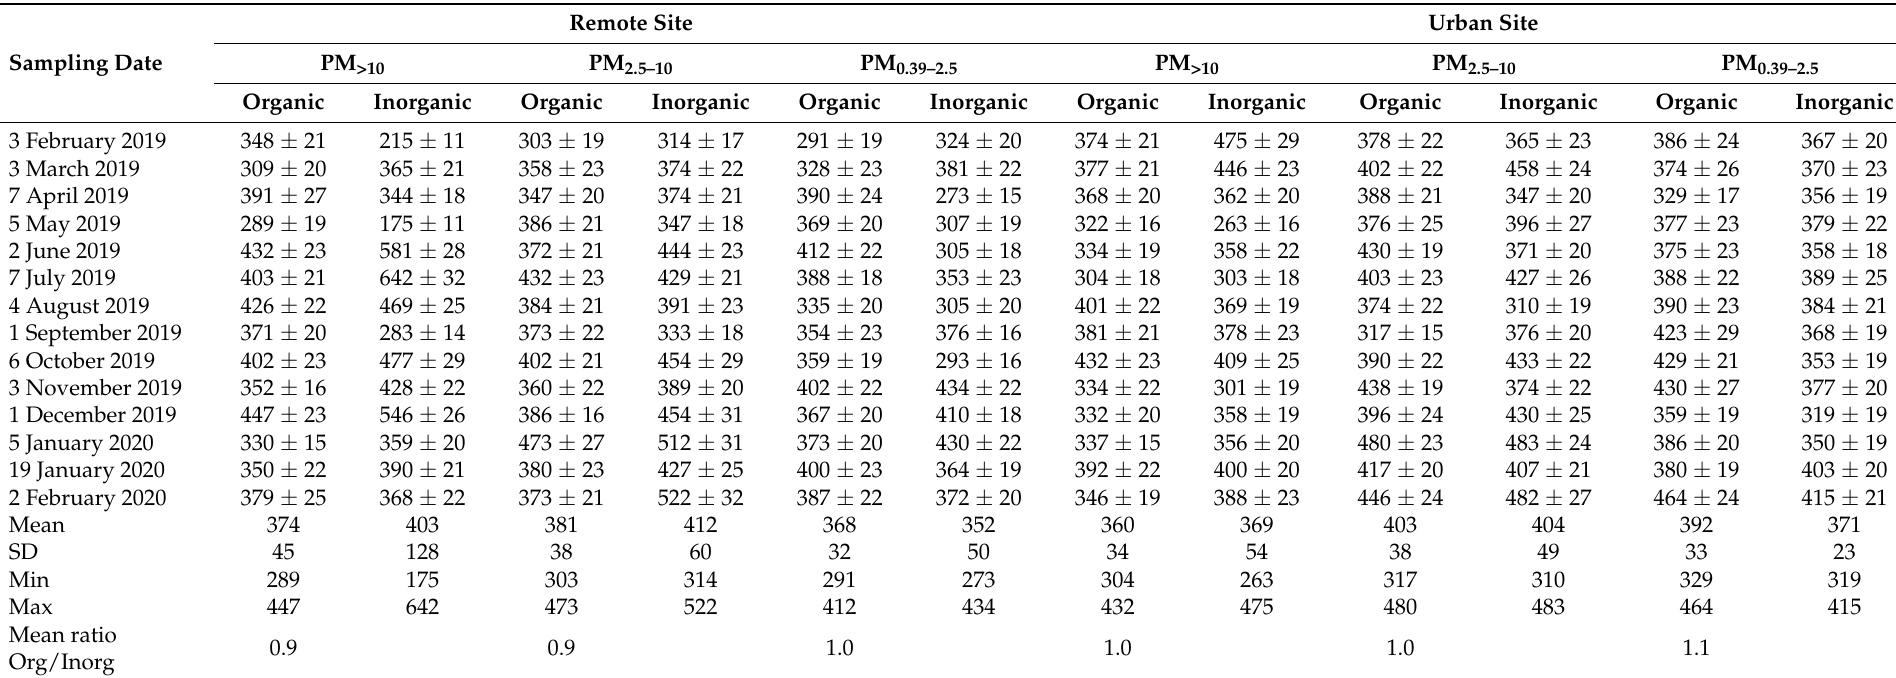
Table 3. Lead-210 activity concentrations (mBq/g dry weight ± 1 σ ) in organic and inorganic components of the size fractioned aerosol